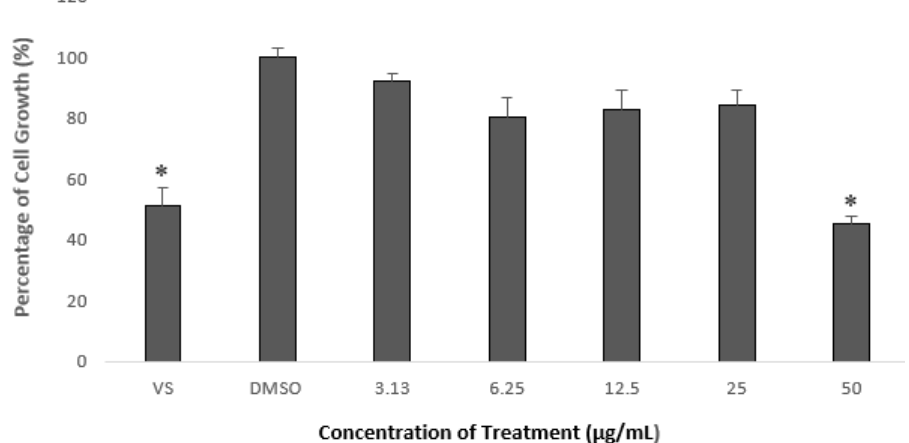
Figure 1. Percentage of HepG2-cell growth after treatment with selected A. planci fractions at 5 different concentrations, from 3.13 to 50 µ g/mL, for 72 h. The percentage of cell growth was compared with that for the negative control of 1% ( v / v ) of dimethyl sulfoxide (DMSO), which was used as the carrier. Data obtained are presented as means ± SDs with n = 6. * denotes significantly different compared with DMSO-treated cells (negative control) at p < 0.05. DMSO was used as the carrier to dissolve and dilute the extract. HepG2 cells were treated with vincristine sulfate (VS) as a positive control.